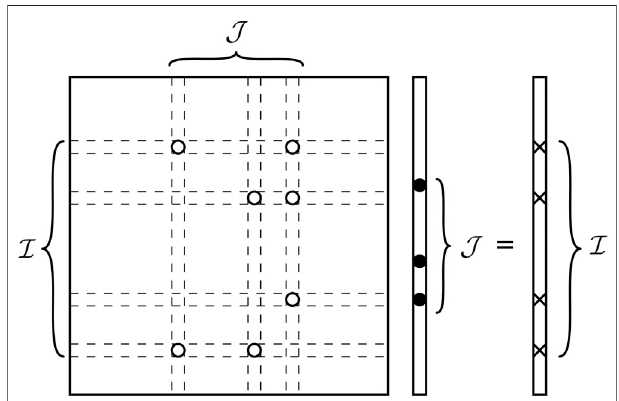
FIGURE 1 | Schematic representation of the restriction applied to system